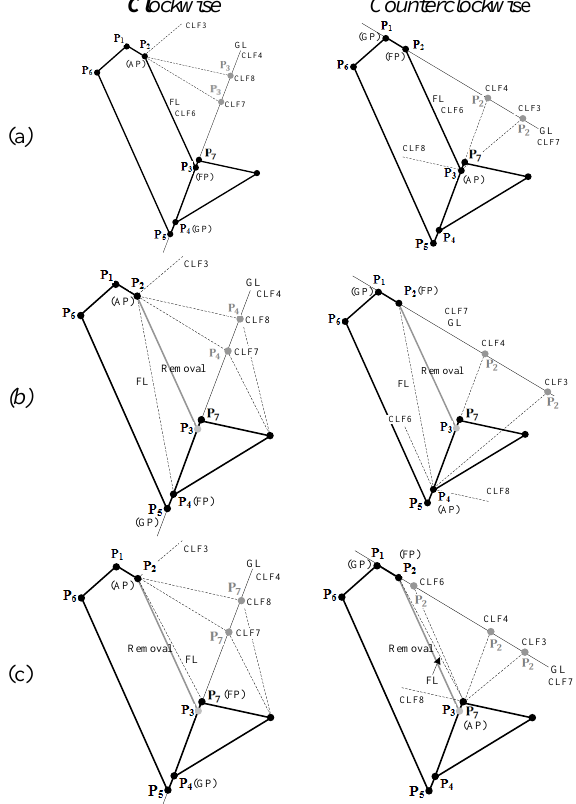
Figure 2. Possible alternative hypotheses by assigning three vertices as AP, FP, and GP : (a) moving FL = {P 2 , P 3 }, (b) eliminating the line {P 2 , P 3 } and moving FL = {P 2 , P 4 }, (c) eliminating the line {P 2 , P 3 } and moving FL = {P 2 , P 7 } in clockwise and counter-clockwise, respectively.